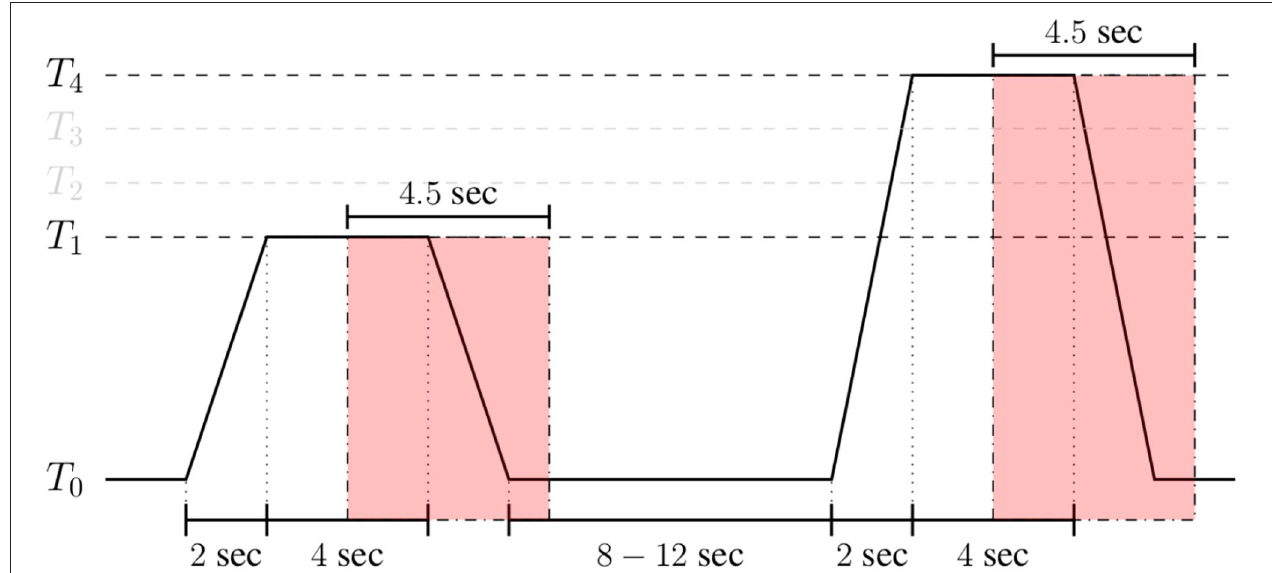
FIGURE 6 | Signal segmentation (BioVid Heat Pain Database). Experiments are carried out on windows of length 4.5 s with a temporal shift of 4 s from the elicitations’ onset.